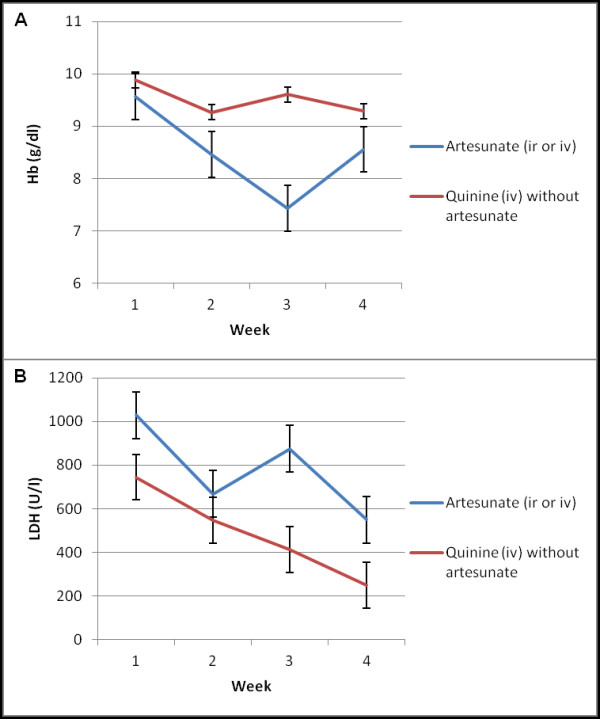
Time course of median weekly Hb (A) and LDH (B) in patients treated with artesunate (n = 8) and in patients treated with quinine (n = 8). ir: intrarectal; iv: intravenous. Mean ± standard error of the mean is displayed.